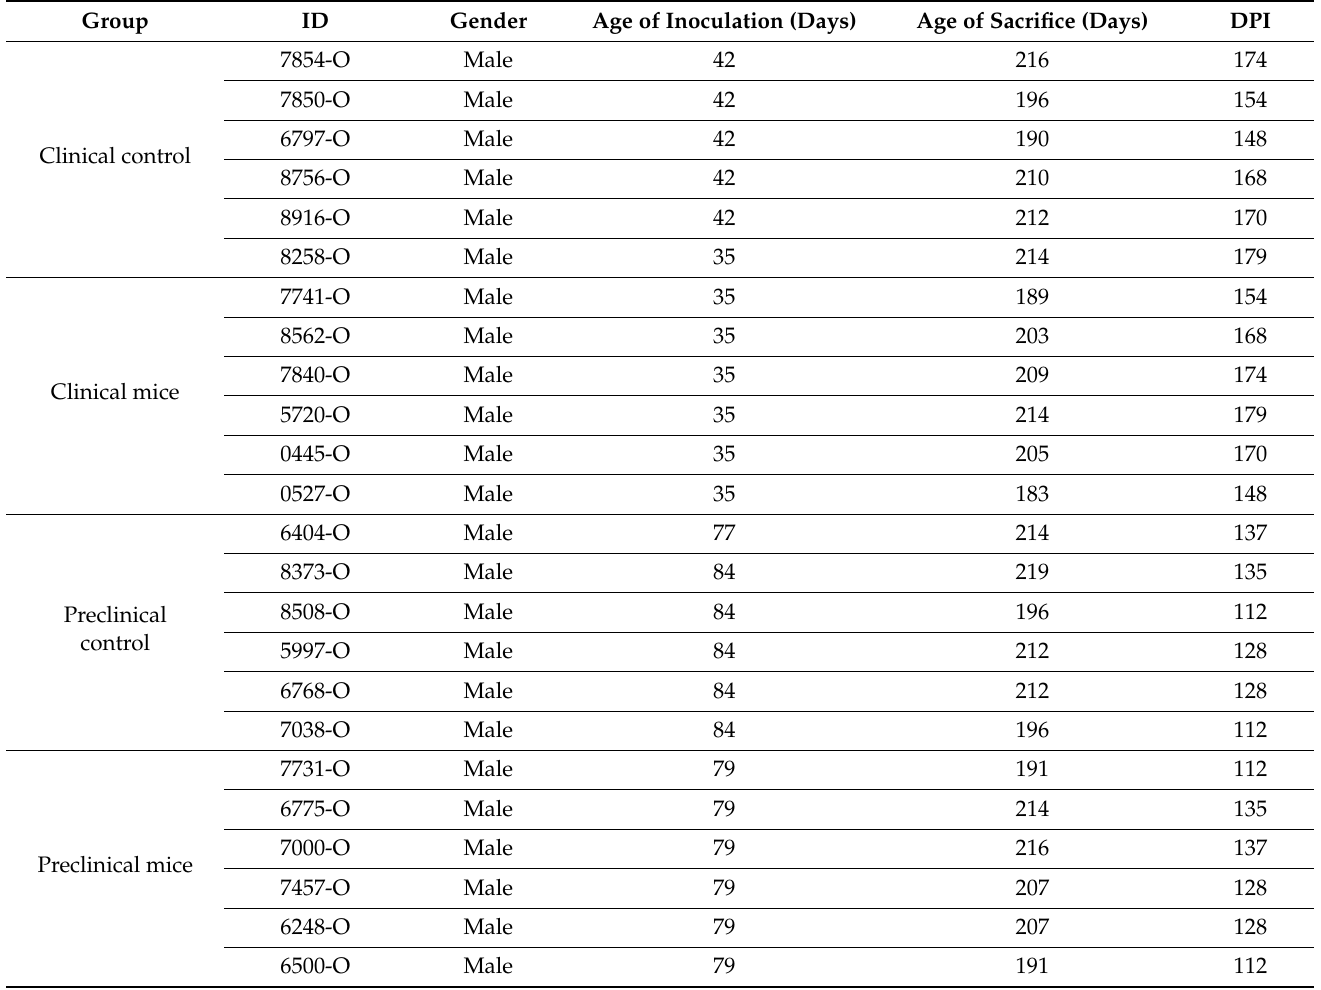
Table 1. Characteristics of the Tg338 mice whose samples were used in this study. ID = mouse identification code and DPI = days post-inoculation at which they were